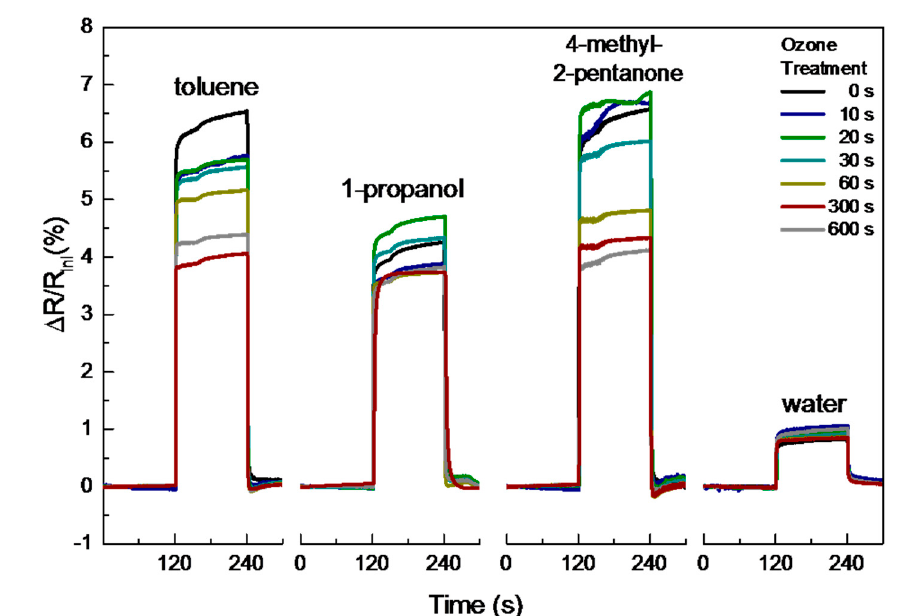
Figure 3. Sensor responses for 5000 ppm of the indicated analyte of the bisdithiocarbamate composites: The black curve is the freshly prepared composite, while the other curves indicate the response of the sensor material after ozone treatment for the indicated